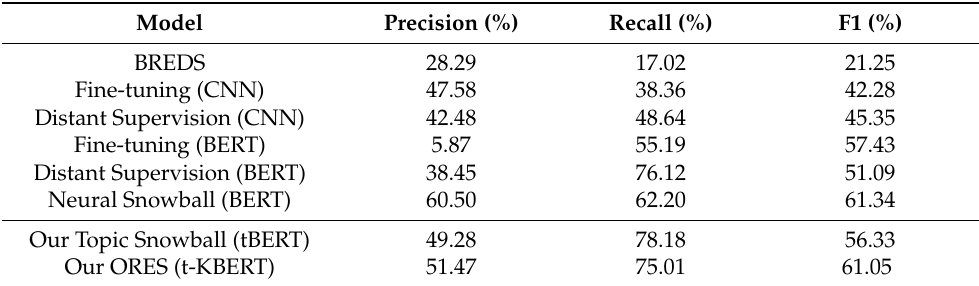
Table 2. The 10-shot experimental results on various previous baseline models.